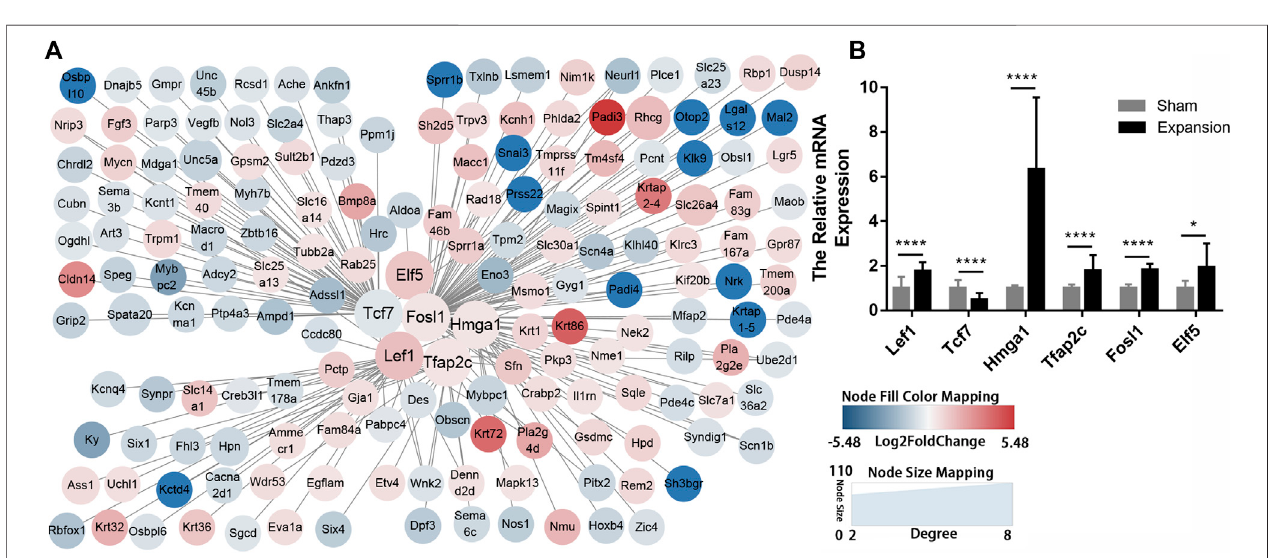
FIGURE 6 | Construction of regulatory networks of TF-mRNA interactions using transcription factor databases (A) Regulatory networks of TF-mRNA interactions activated by mechanical stretch (B) The relative mRNA levels of LEF1, TCF7, ELF5, FOSL1, TFAP2C, and HMGA1 using qPCR. * p < 0.05, **** p < 0.0001.